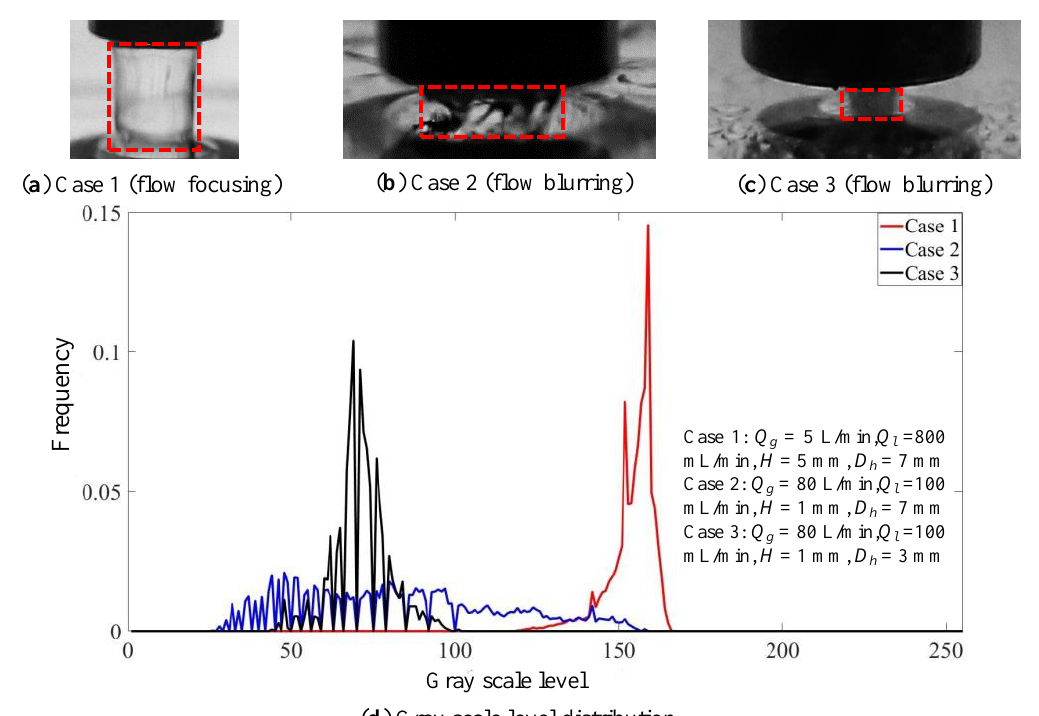
Figure 4. Different flow pattern images and their gray distribution in the mixing zone.